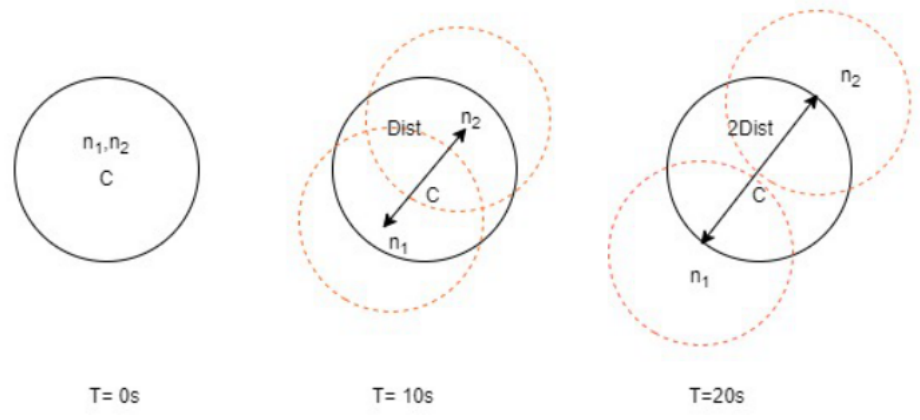
Figure 2. Distance measurements of mobile